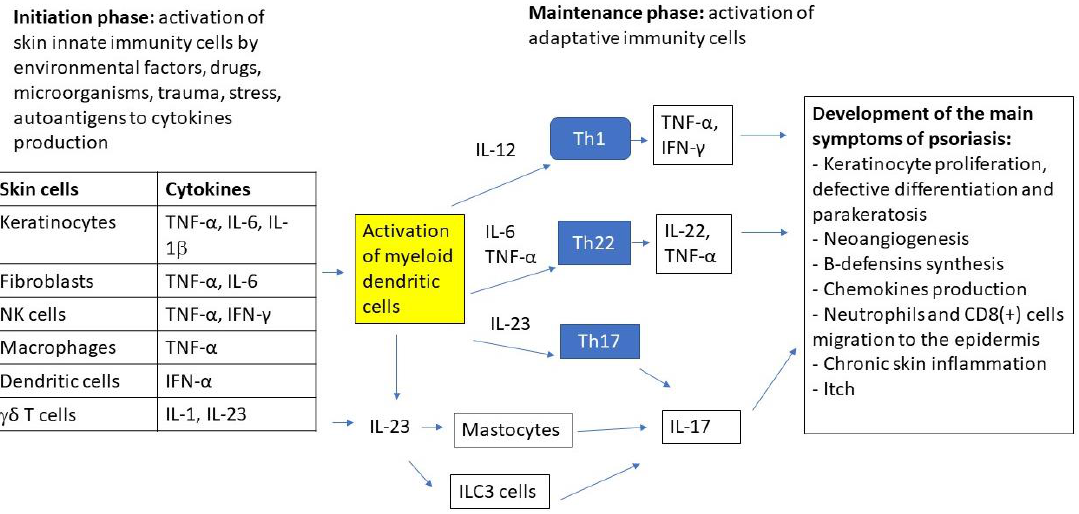
Figure 1. The major effector cells and signaling pathways in the immunopathogenesis of psoriasis.